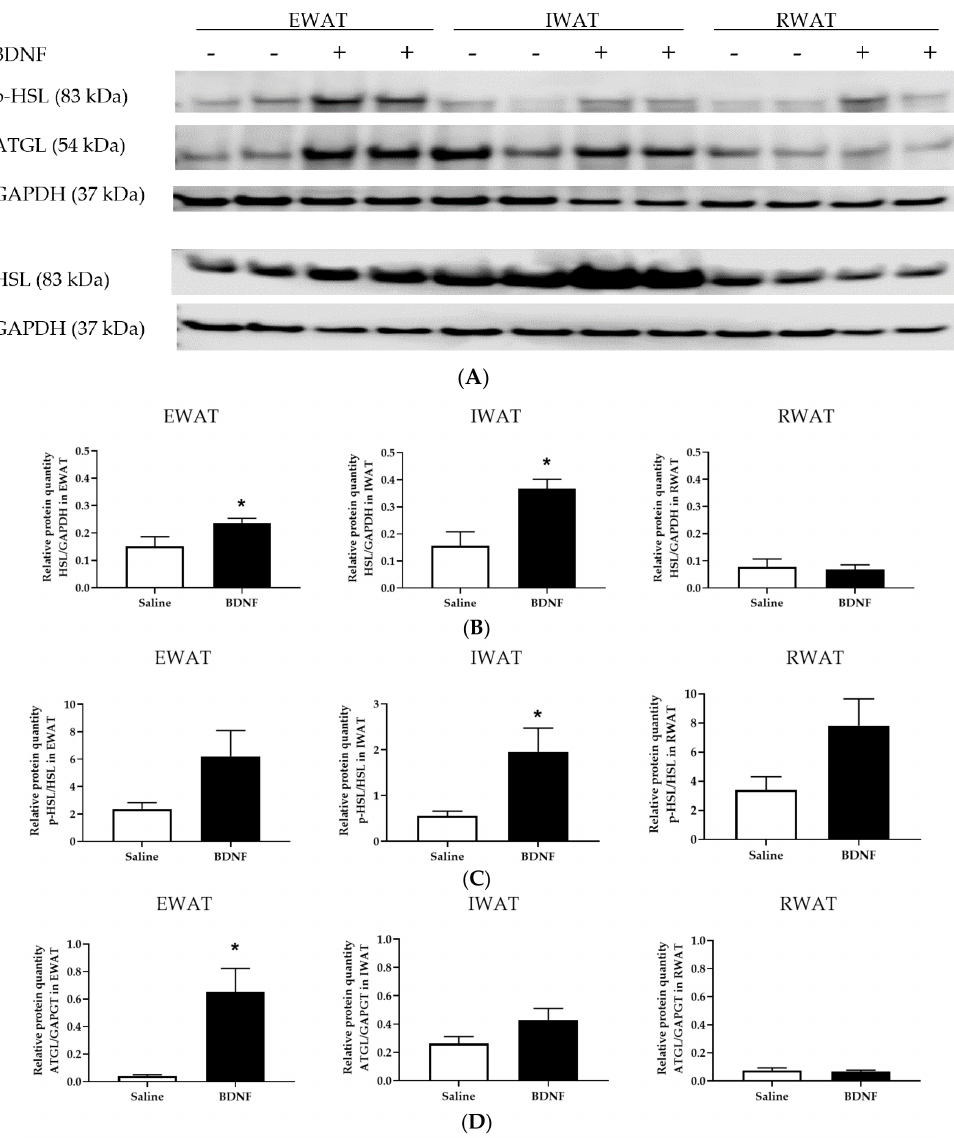
Figure 2. Expression of lipolytic proteins involved in lipid mobilization in white adipose tissues of